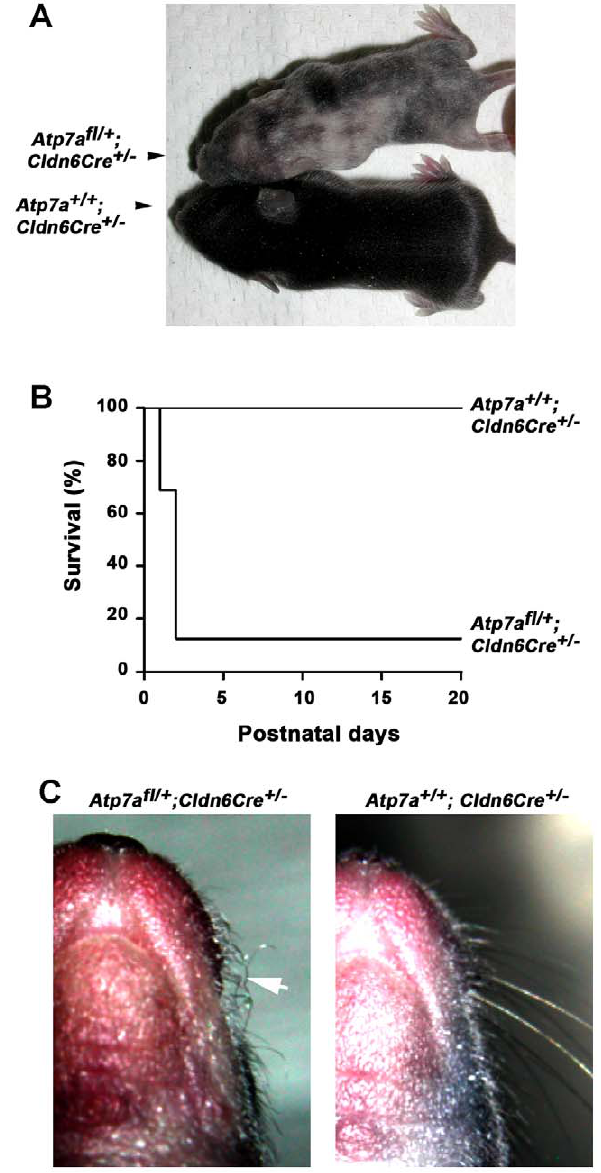
Figure 2. Characterization of Atp7a fl/ + ; Clnd6Cre + / 2 heterozy- gous female mice. A) Patches of hypopigmentation are observed in the coats of weanling heterozygous Atp7a fl/ + ; Clnd6Cre + / 2 females. B) Kaplan-Meier plot showing postnatal survival of heterozygous Atp7a fl/ + ; Clnd6Cre + / 2 female (n=16) and littermate control Atp7a + / + ; Clnd6Cre + / 2 (n=34). C) Pili torti of the whiskers in surviving Atp7a fl/ + ; Clnd6Cre + / 2 females is shown (arrow).